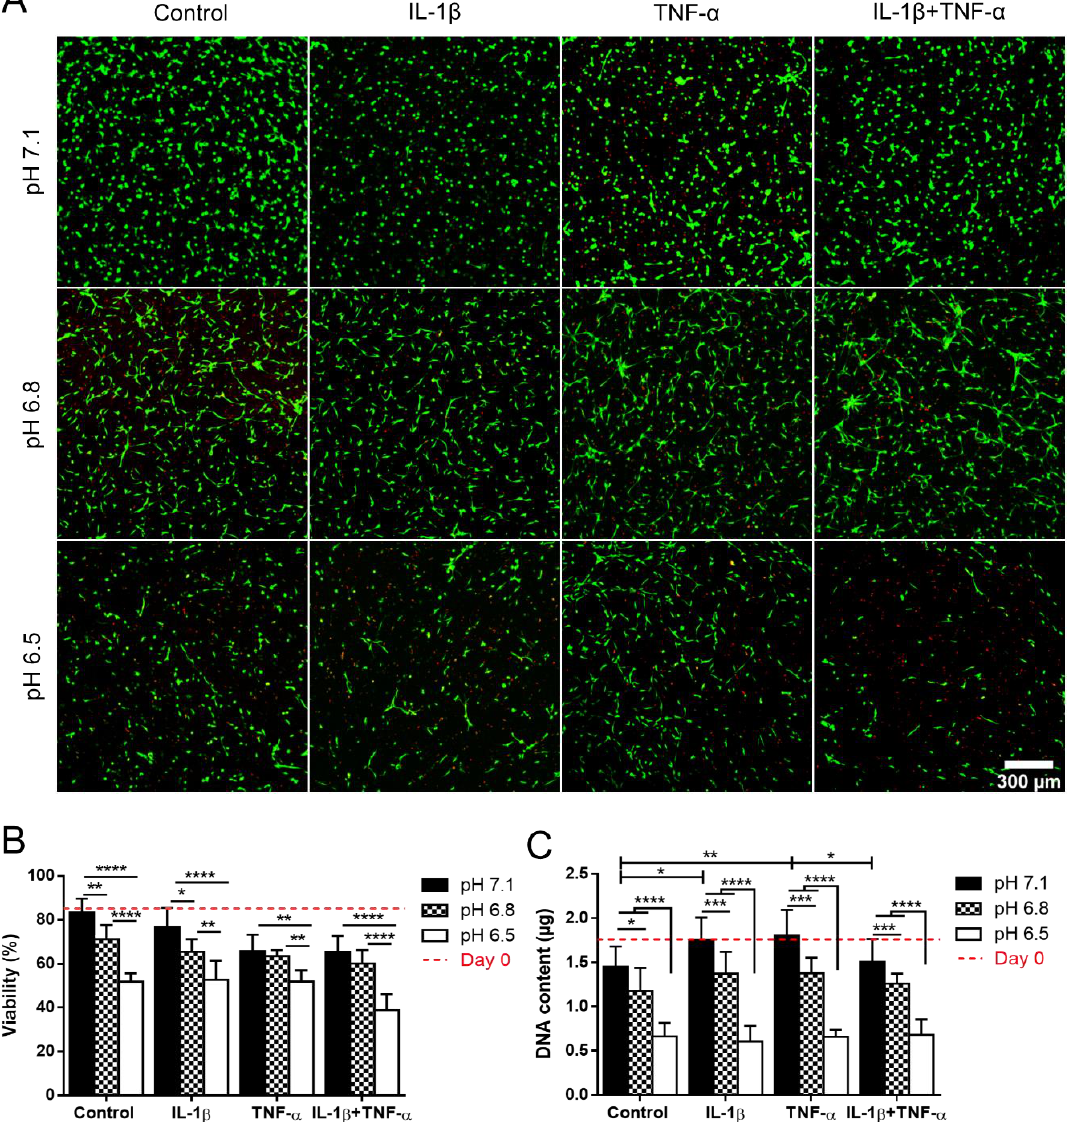
Figure 2. ( A ) Live/dead images of NCs at day 14 cultured in 3D hydrogels in pH modified media (pH 7.1, 6.8 and 6.5) either unsupplemented (control) or supplemented with IL1-β and TNF-α or a combination of both. Scale bar is 300 μm. ( B ) Cell viability (%). ( C ) DNA content (μg) of hydrogels at day 14. * ( p < 0.05), ** ( p < 0.01), *** ( p < 0.001) and **** ( p < 0.0001) indicate significant differences between groups. N = 3 donors, n = 3 samples.